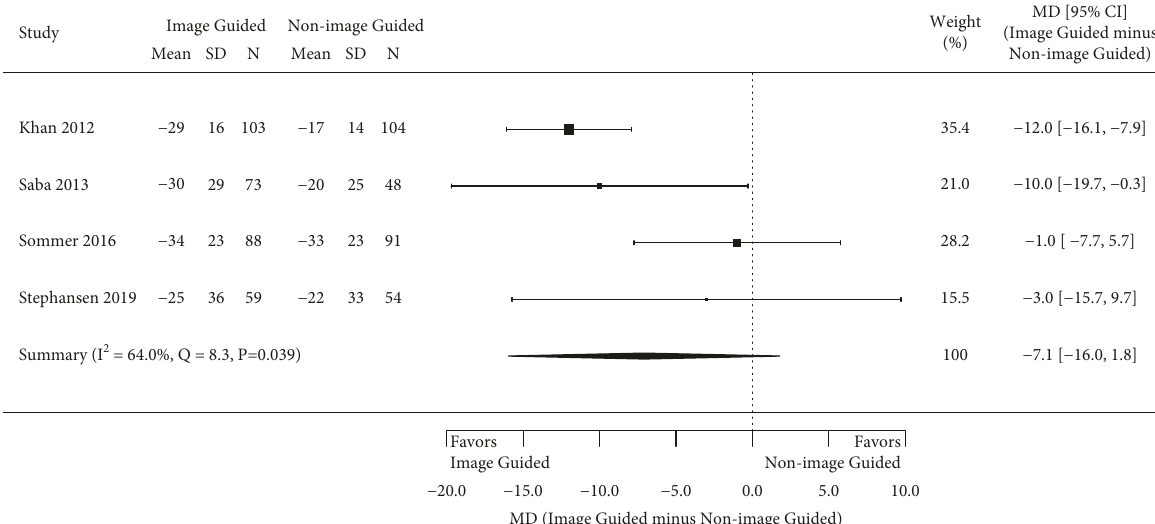
Figure 3: Mean relative reduction in LVESV at 6